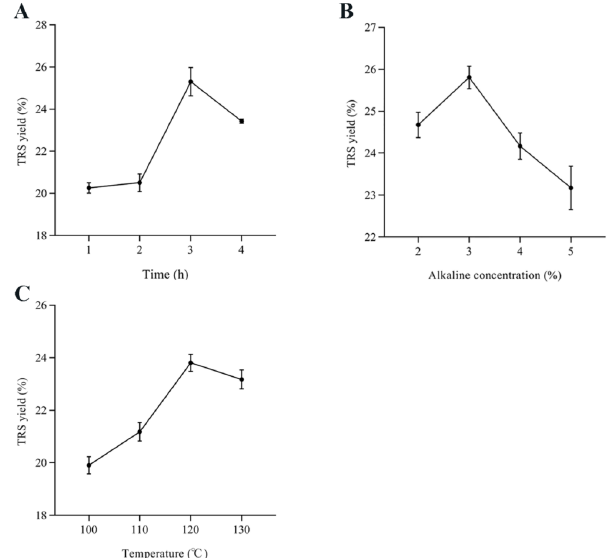
Figure 2. Effects of different alkali-pretreated parameters on TRS yield. Panels ( A – C ) show the effects of reaction time, alkaline concentration, and temperature on TRS yield, respectively. Table 3. Orthogonal analysis of alkali pretreatment parameters.